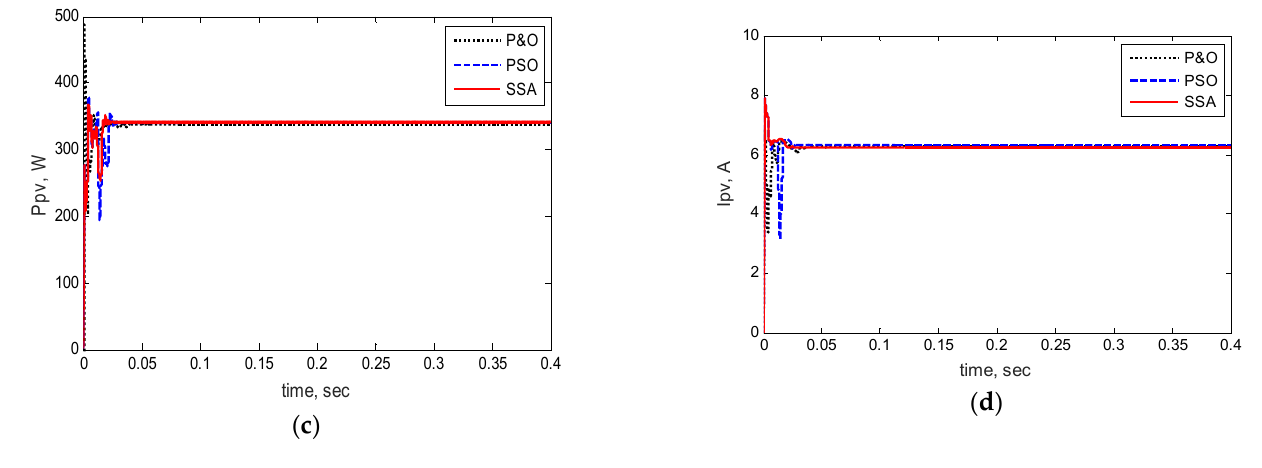
Figure 11. Photovoltaic panel tracking curves using P&O, PSO, and SSA methods in the condition of shade pattern 2: ( a ) Vpv, ( b ) Ipv, ( c ) Ppv, ( d ) duty cycle.